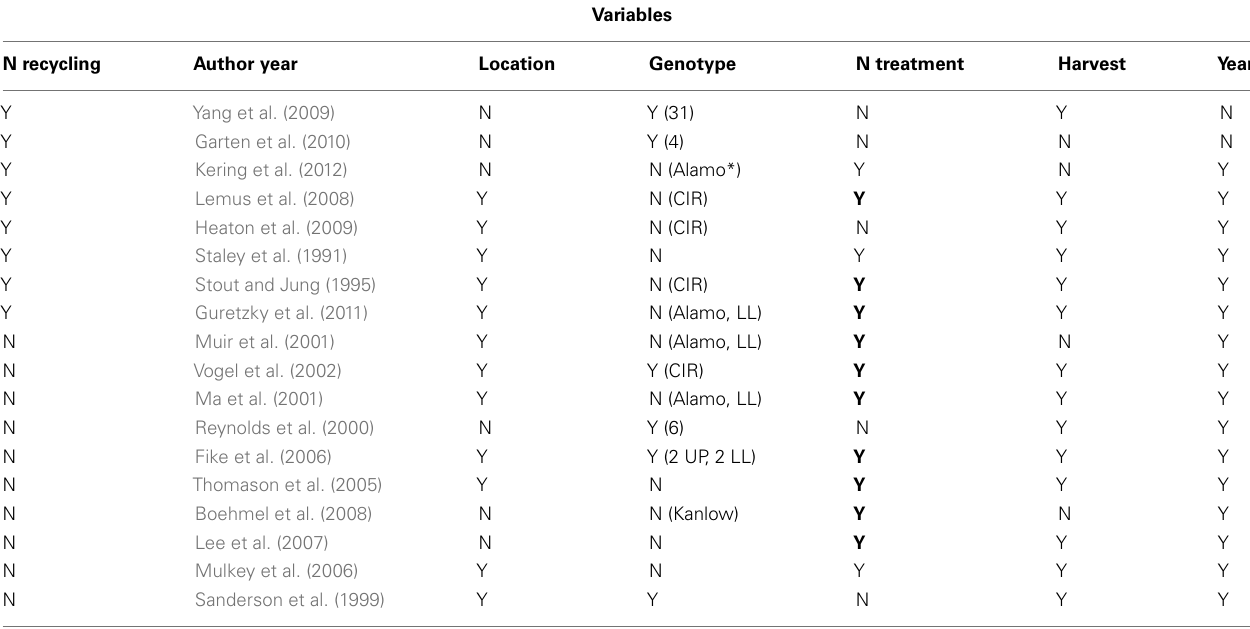
Table 1 | Studies investigating N dynamics and yield in